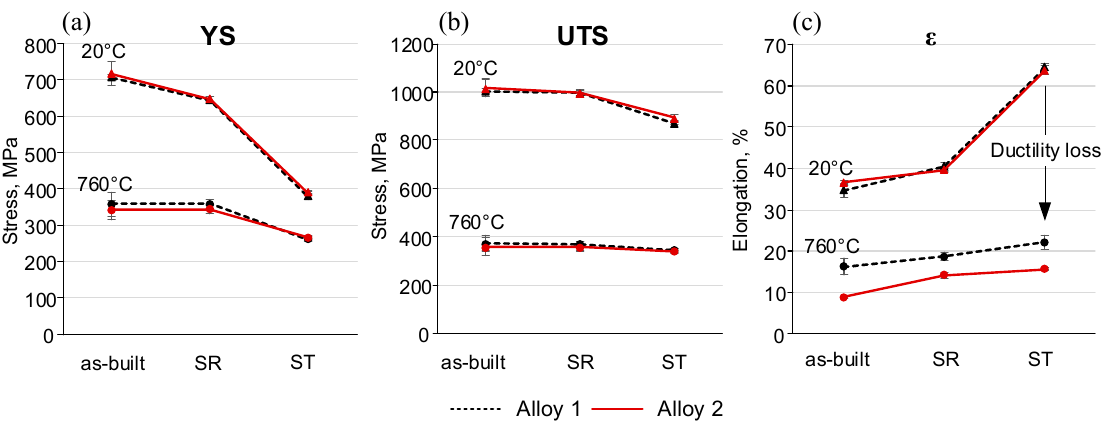
Figure 15. Mechanical properties (at 20 °C and 760°) of Alloys 1 and 2 in the as-built state and after the SR and ST treatments: ( a ) yields stress (YS), ( b ) ultimate tensile strength (UTS) and ( c ) elongation to failure ( ε ).